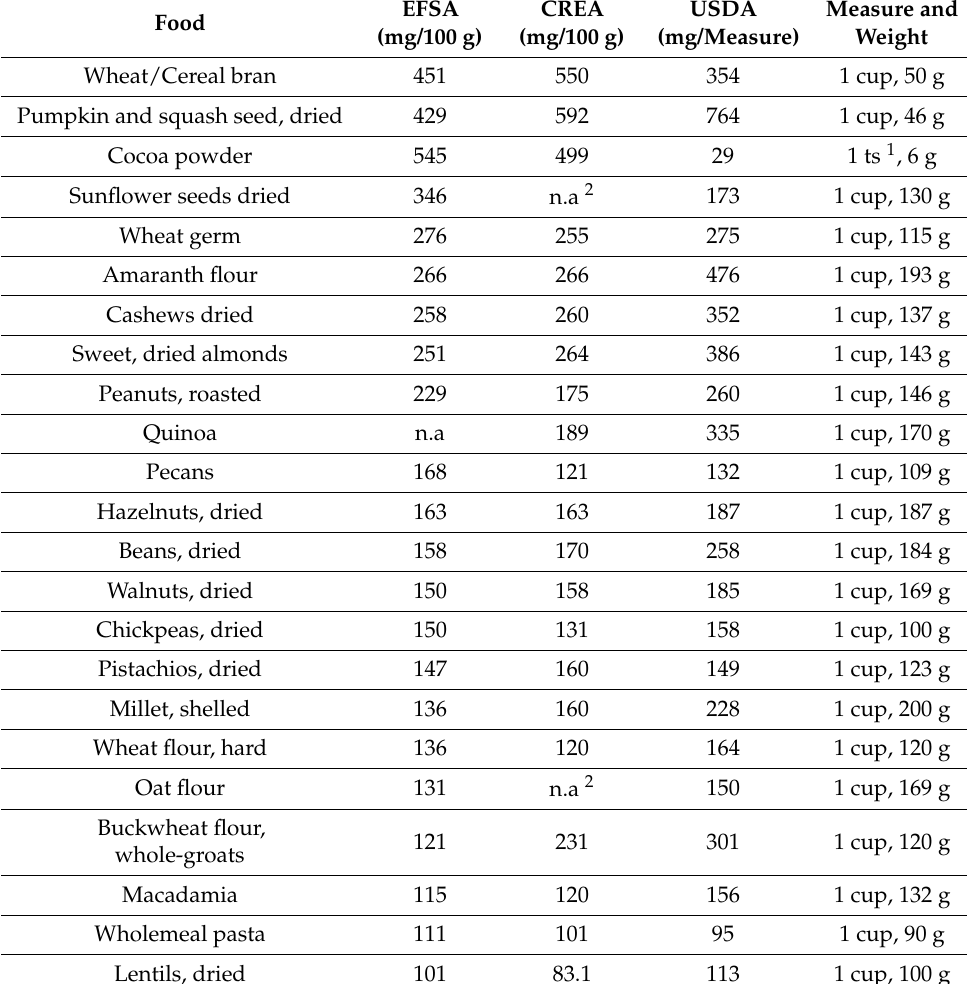
Table 3. Magnesium content in Food according to the EFSA Comprehensive European Food Con- sumption Database (CREA) and U.S. Department of Agriculture, Agricultural Research Service— Food Data Central.